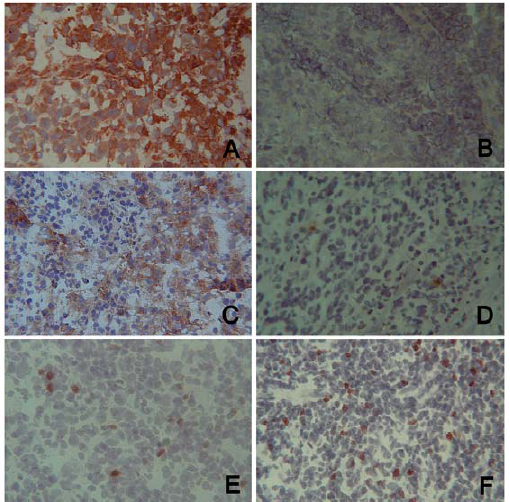
Figure 3. Representative pictures of MHC class I, ICAM-1 and Foxp3 expression using immunohistochemistry on tumor specimens of melanoma invaded LN. (A) and (B): MHC class I expression, (C) and (D): ICAM-1 expression, (E) and (F): Foxp3 expression (magnification 6 25). (A), (C) and (E) are specimens from the group with only one invaded LN whereas (B), (D) and (F) are specimens from the group with more than one invaded LN.